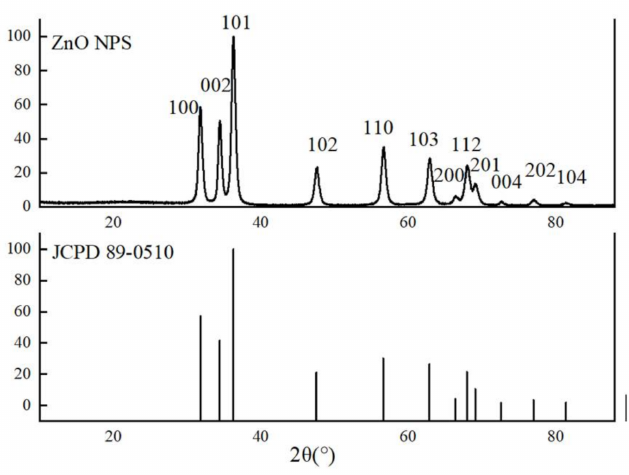
Figure 2. XRD patterns of ZnO